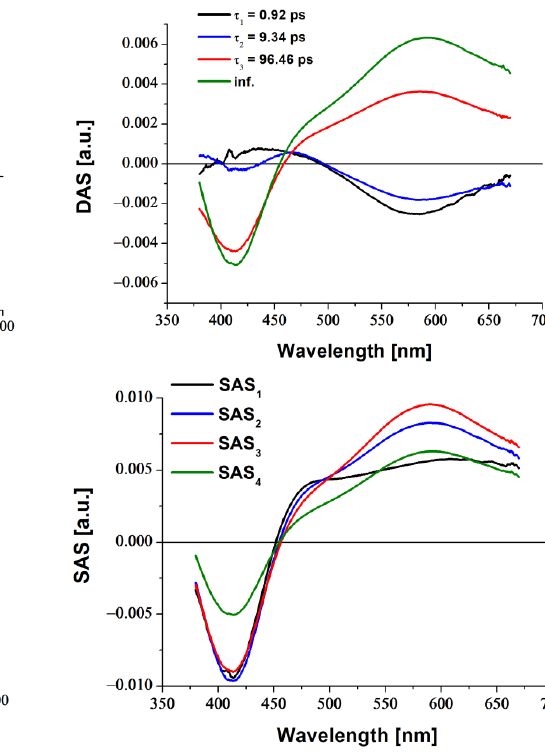
( c ) ( d ) Figure 10. The fsTA 2D maps ( a ) and TA spectra at selected time delays ( b ), decay associated spectra (DAS i ) ( c ), and species associated spectra (SAS i ) ( d ) for complexes 1 and 2 in chloroform.